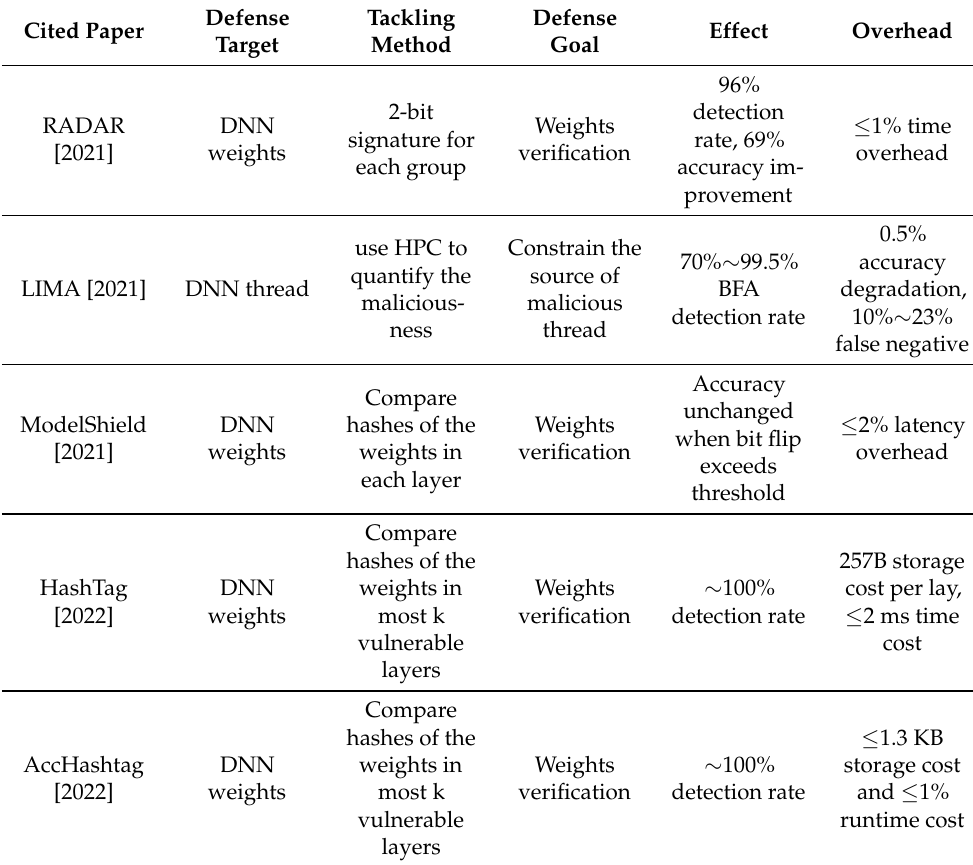
Table 10. The attributes of works that aims to use some features for detecting